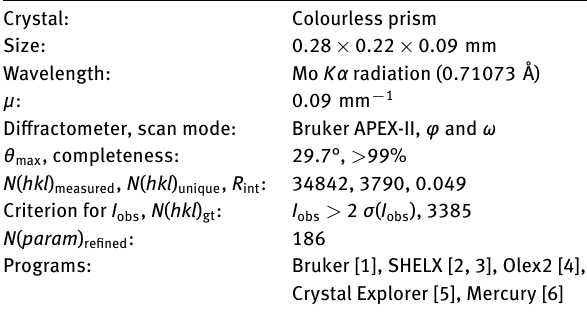
Table 1: Data collection and